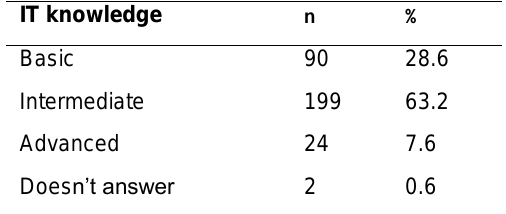
Table 1. Classification of the sample subjects’ IT knowledge